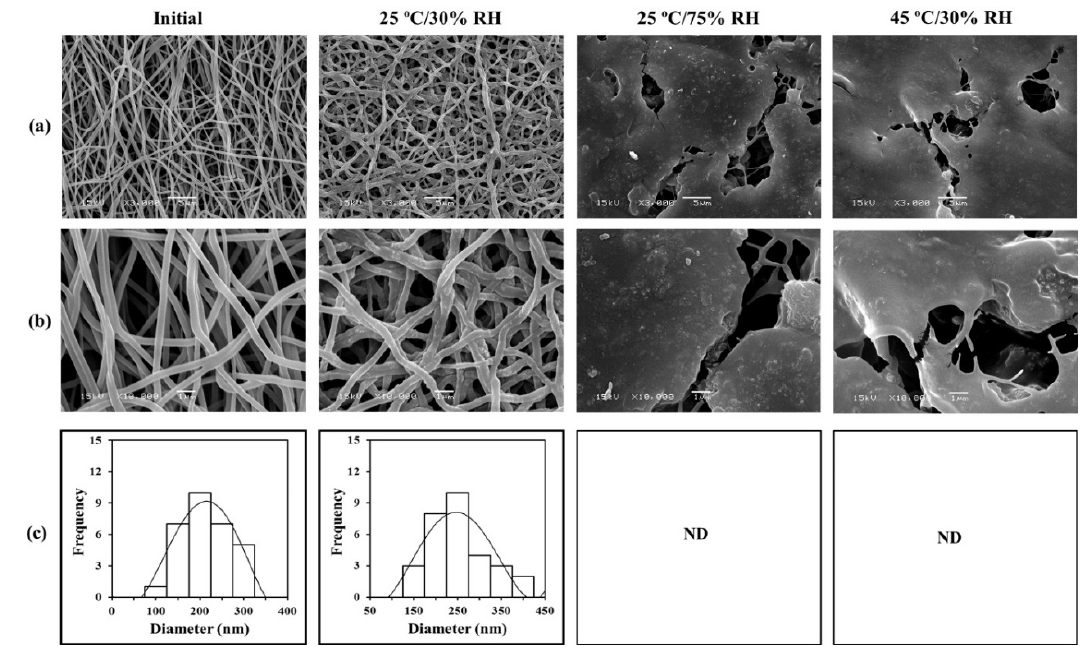
Figure 4. SEM images of CP-F at initial measurement and after storage at various conditions for 12 months, ( a ) at 3000× magnification, ( b ) at 10,000× magnification, and ( c ) the average diameter (ND: not detectable).